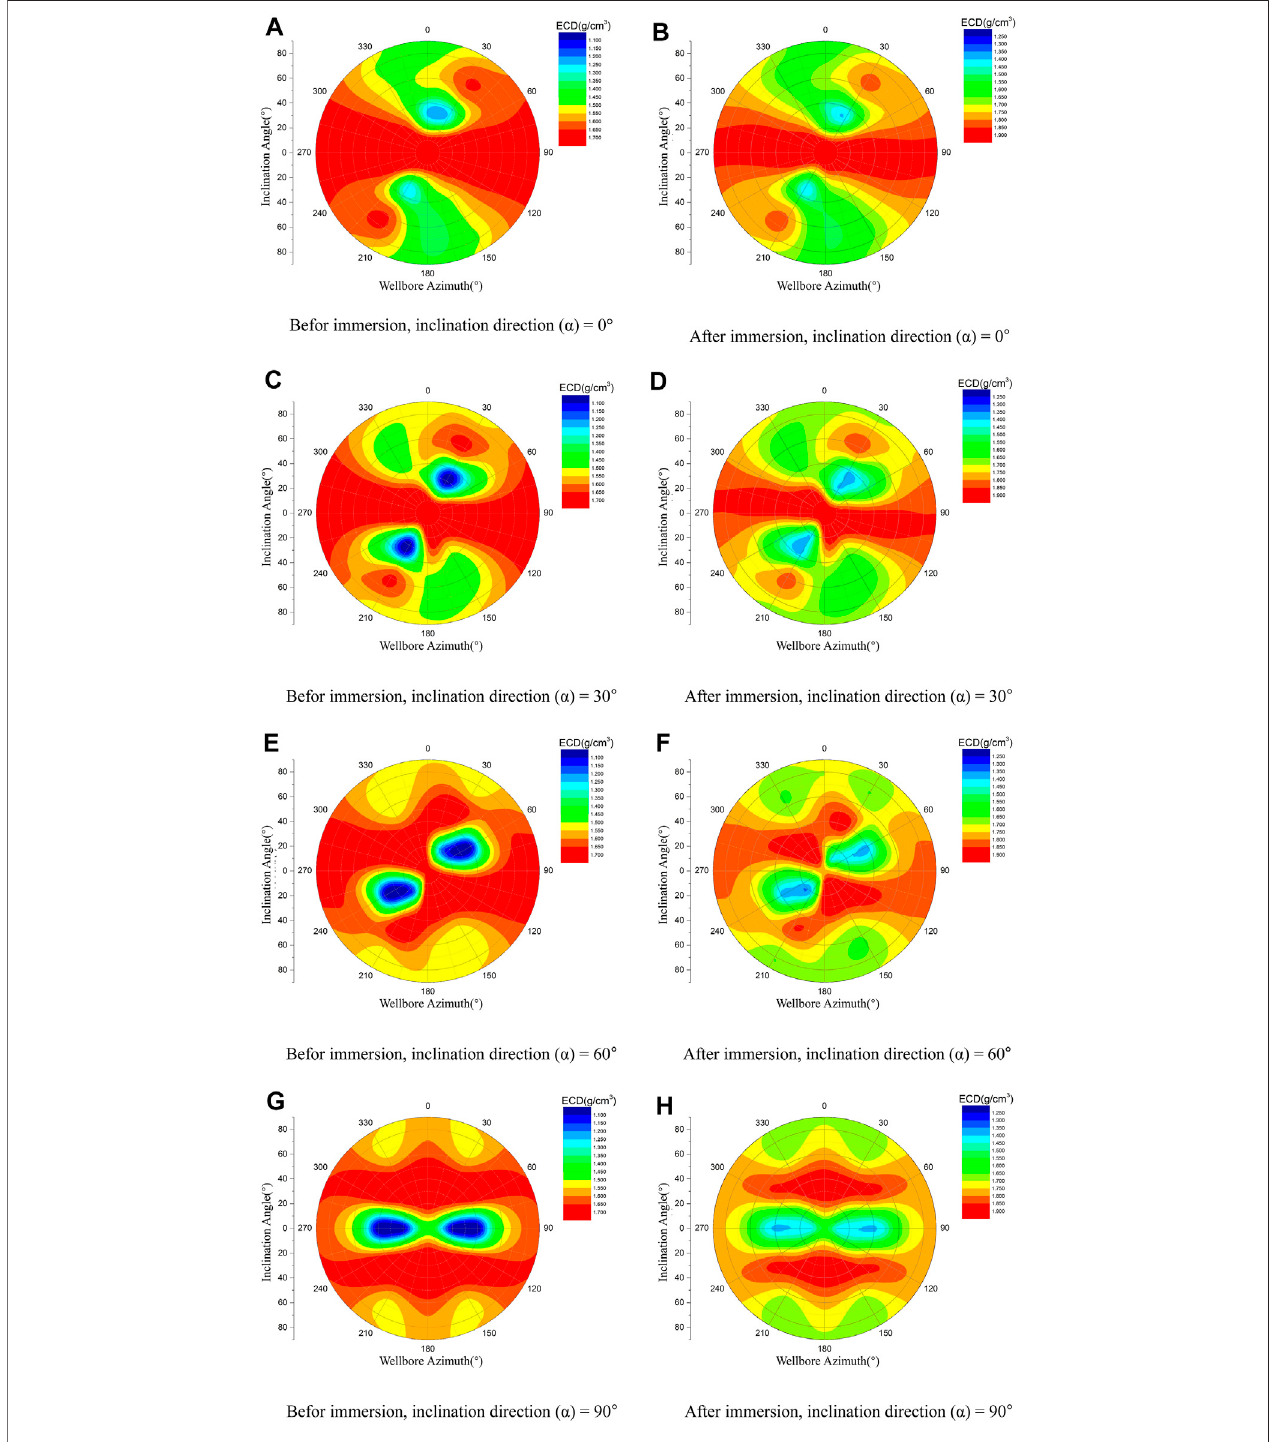
FIGURE 9 | The collapse pressure before and after soaking, when the bedding inclination angle ( β ) is 30 ° .